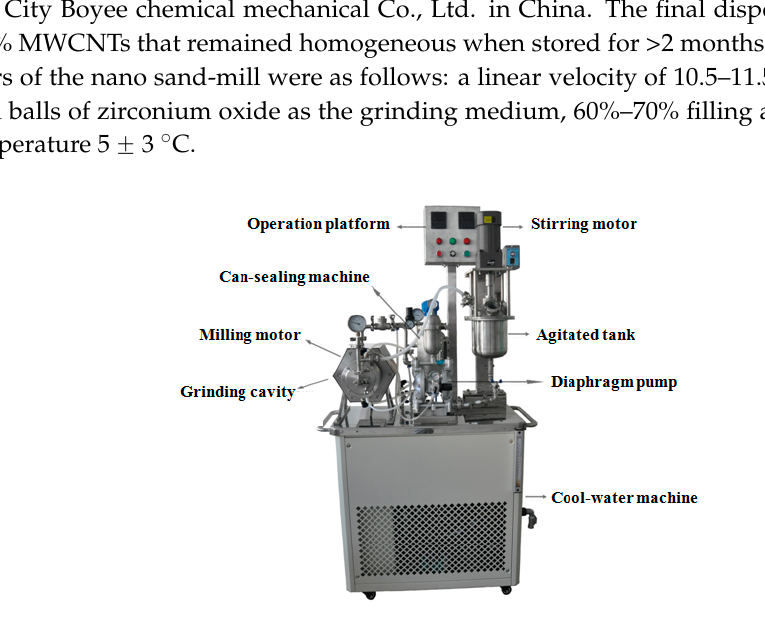
Table 2. Chemical composition and physical properties of C, SF, and BS. LOI, SG, and SSA are the abbreviation of loss on ignition, specific gravity, and specific surface area, respectively.